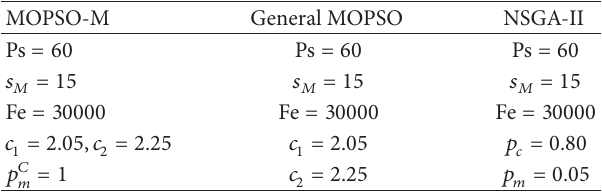
Table 3: Main parameter settings of the three